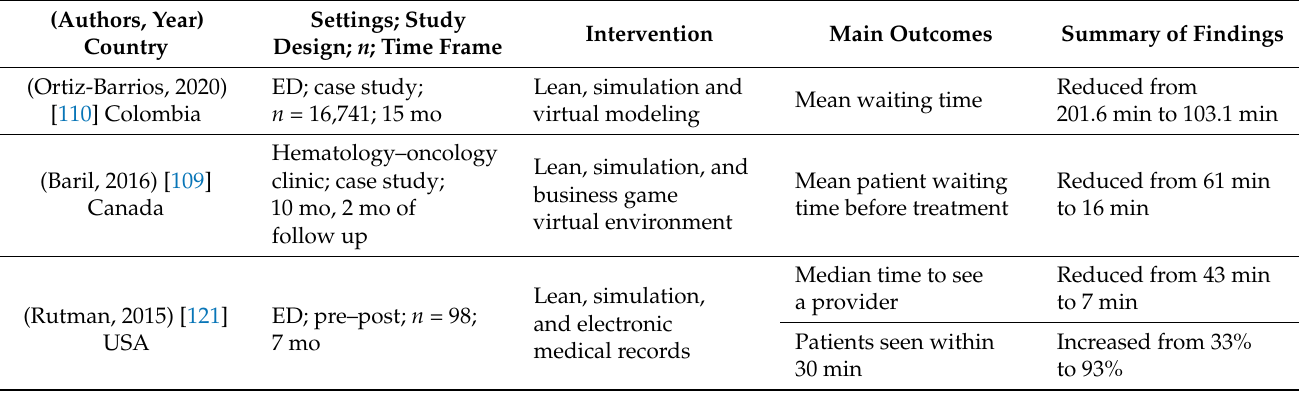
Table 4. Waiting time outcomes of LH interventions supported by